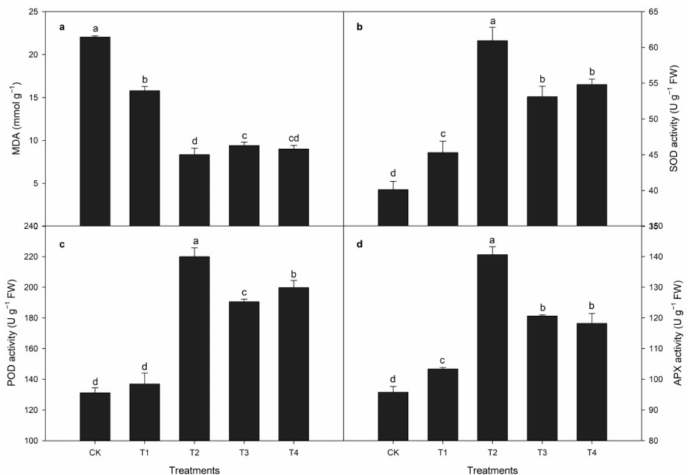
Figure 4. Effects of CaCl 2 treatment of different concentrations on the ( a ) MDA activity; ( b ) SOD activity; ( c ) POD activity; and ( d ) APX activity in Rosa hybrida under heat stress treated with 50 µ M CaCl 2 (T1), 100 µ M CaCl 2 (T2), 150 µ M CaCl 2 (T3), 200 µ M CaCl 2 (T4), or H 2 O as the control (CK). Each vertical line shows the standard error ( n = 10). The values are described as means ± SD; different letters denote significant differences ( p < 0.05) according to Duncan’s multiple range